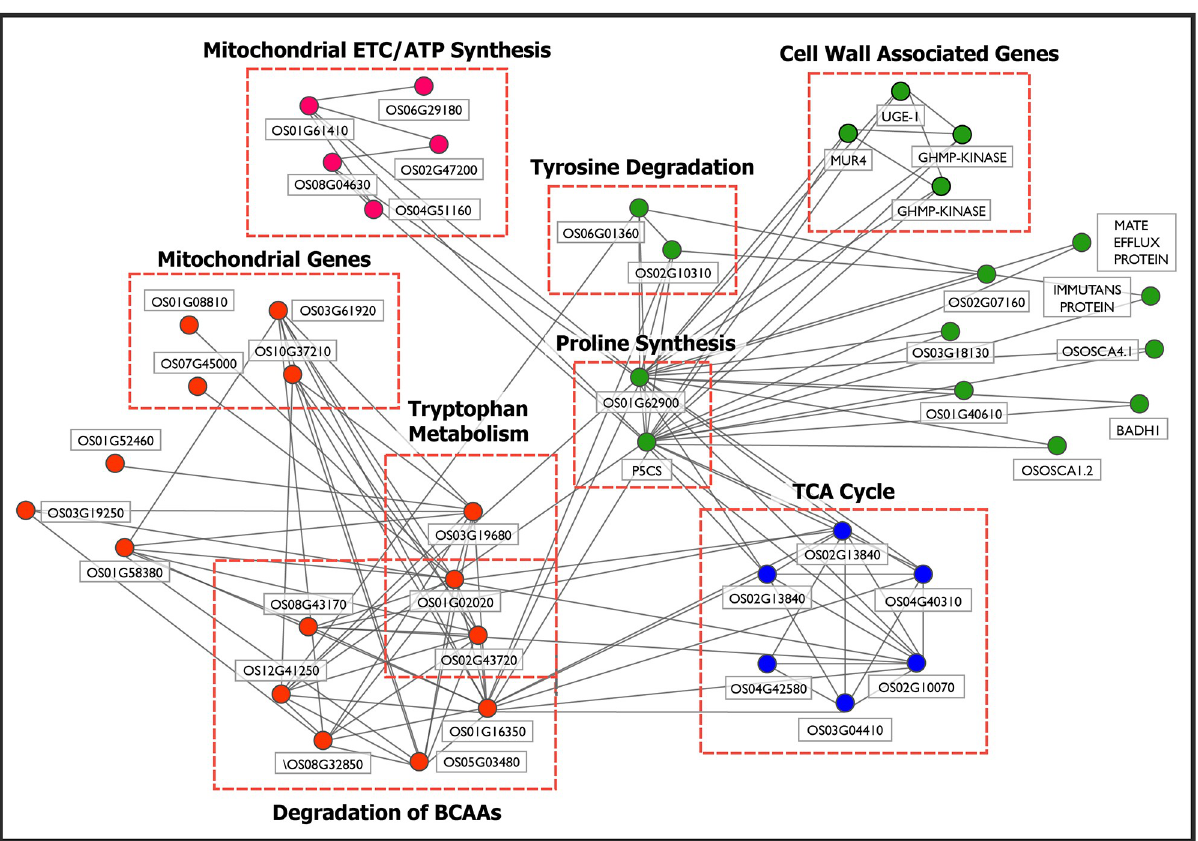
Fig 4. Subnetwork of Cluster U3 (‘green’), Cluster U4 (‘orange’), Cluster U9 (‘blue’) and Cluster U11 (‘pink’) obtained using MCL algorithm on up-regulated drought-tolerant network (uDTN) is shown. It depicts the crosstalk between the components of Amino Acid Metabolism (Cluster U3 and U4), Cell Wall metabolism (Cluster U3), TCA/Citric Acid Cycle (Cluster U9) and ATP synthesis (Cluster U4). These interactions indicate link between structural integrity of plant and cellular energy generating processes as a drought-adaptive mechanism.